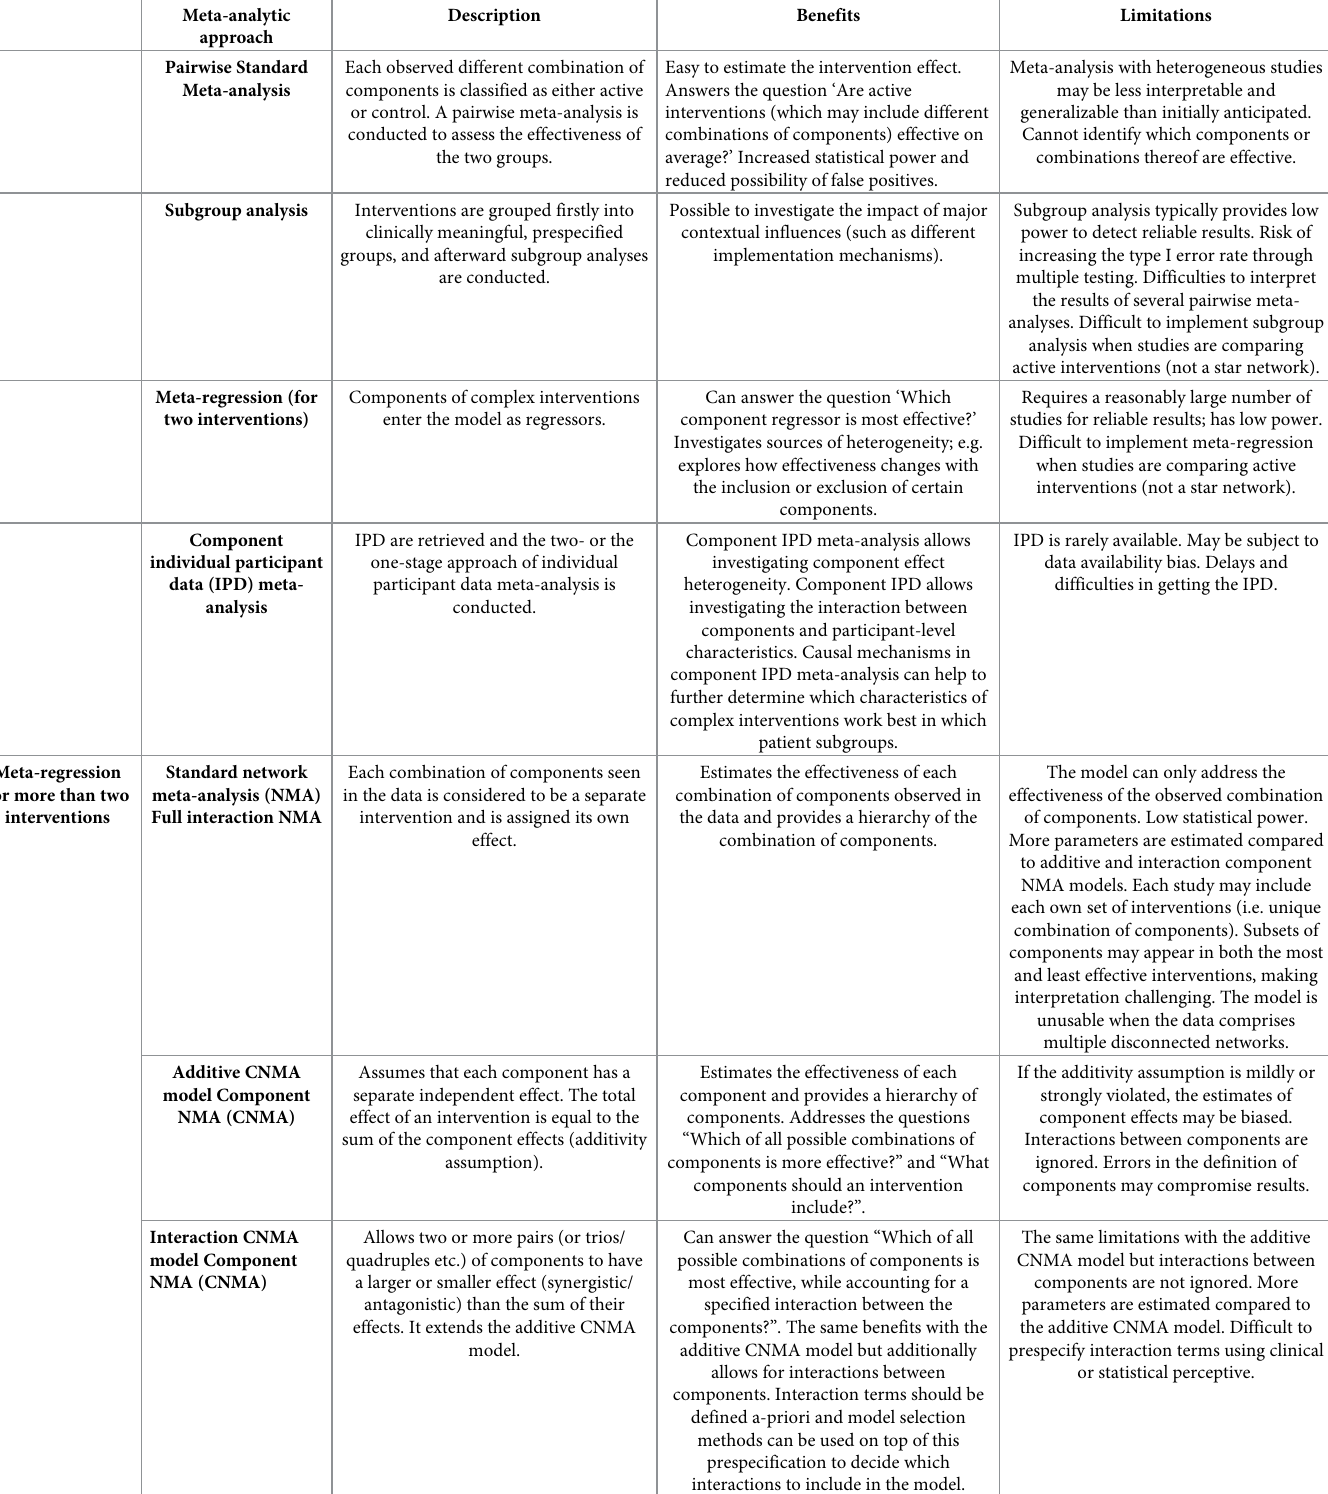
Table 2. Description, benefits, and limitations of the meta-analytical approaches that evaluate the effects of complex